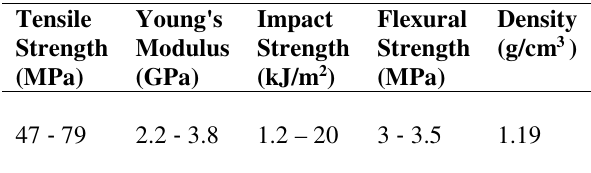
Some Mechanical and Physical Properties of PMMA Resin.